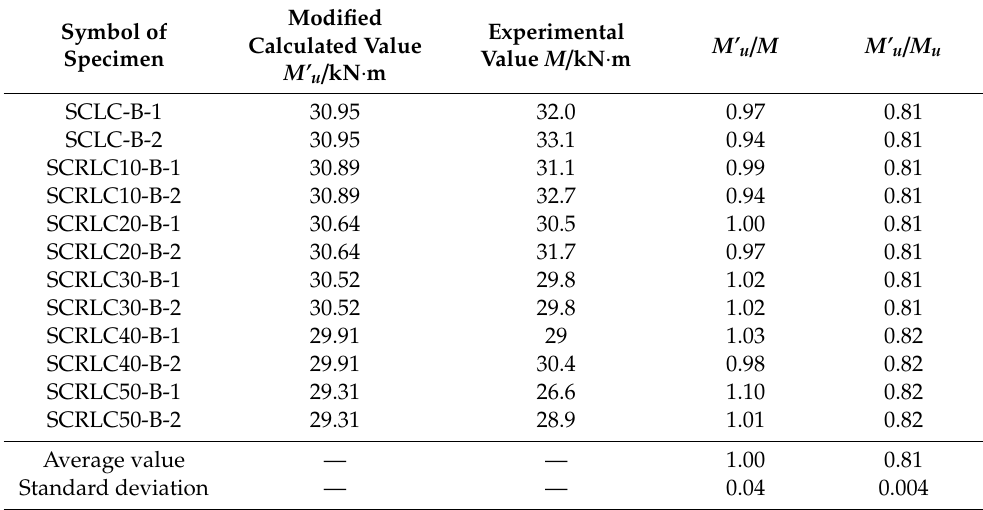
Table 12. Comparison between experimental and modified calculated value of the bending moment of composite